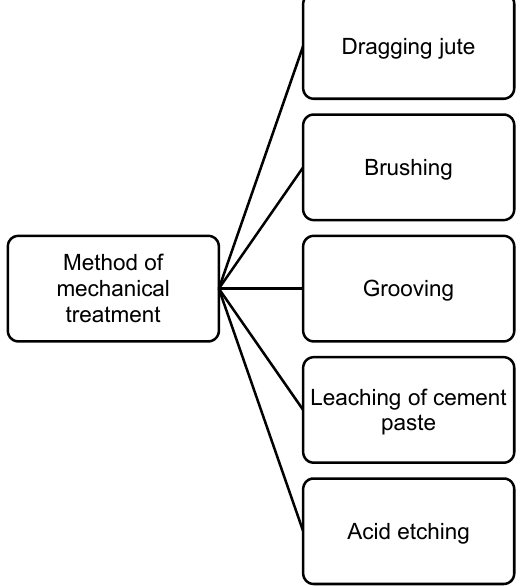
Figure 13. Division of concrete texturing methods.